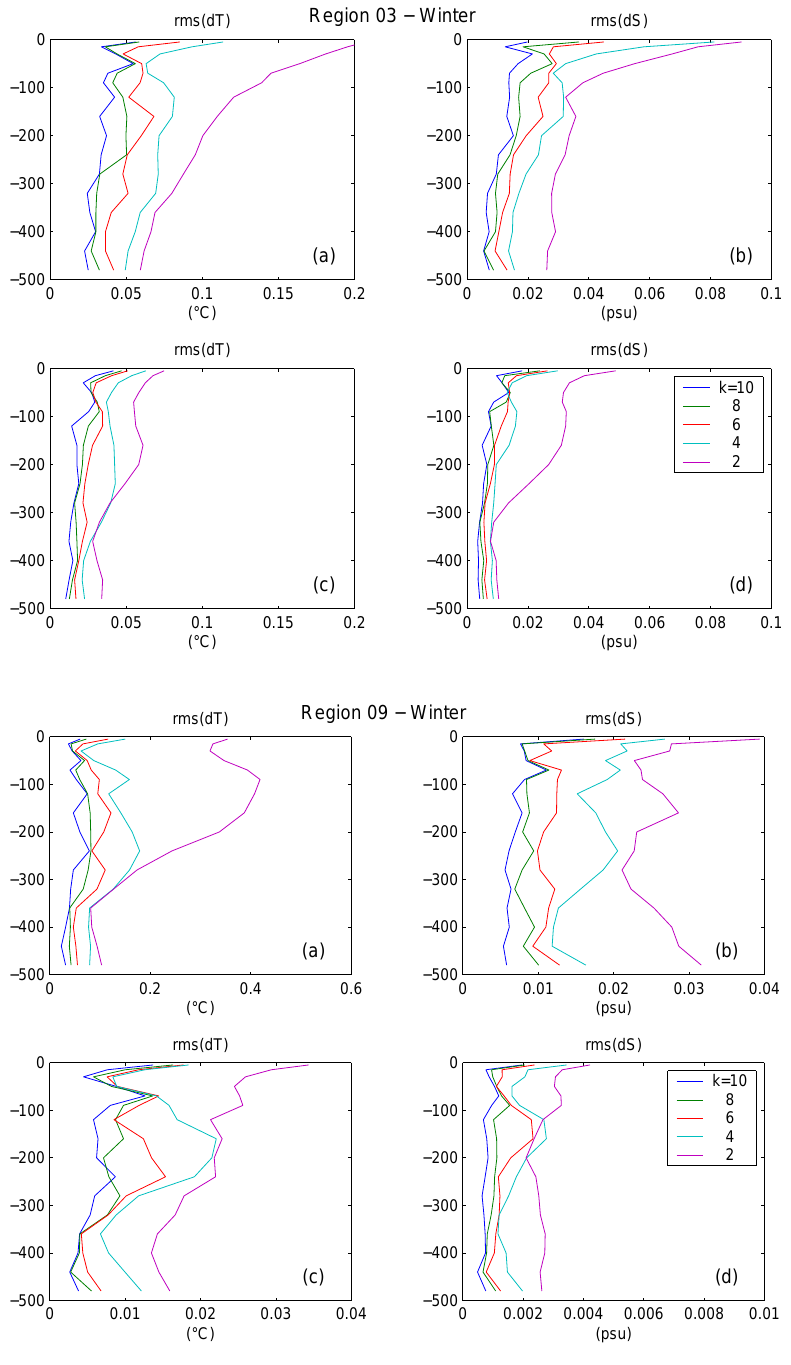
Fig. 11. RMS residual errors of tem- perature and salinity for region 9 in winter obtained by projecting the insitu data on a k-order EOF subspace, with k = 2 , 4 , 6 , 8 and 10 when EOFs from insitu data ( a and b ) and model data ( c and d ) are